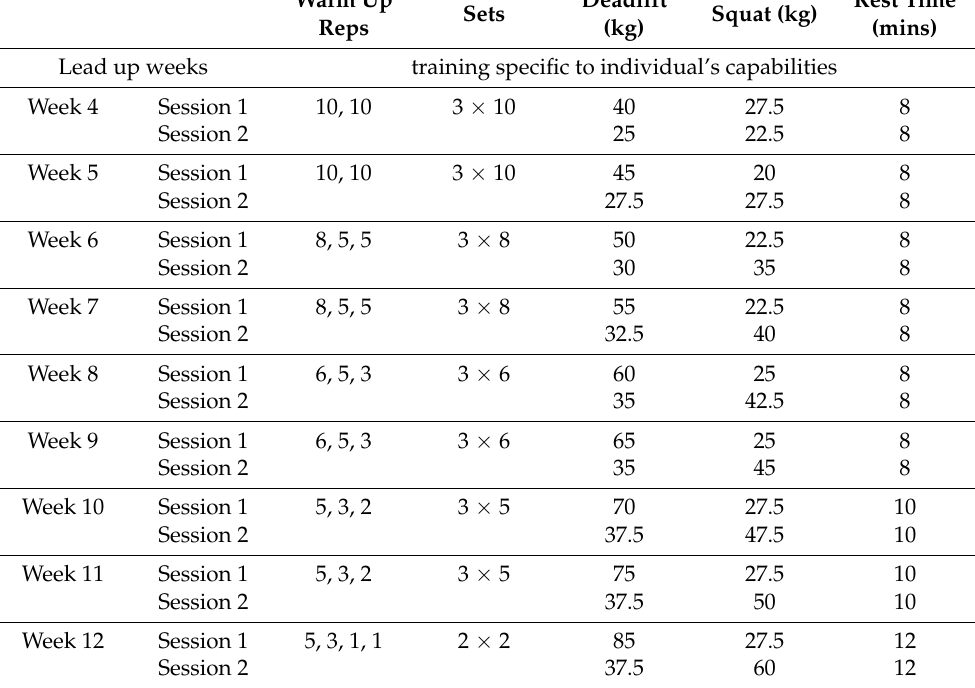
Table 1. Example of a training